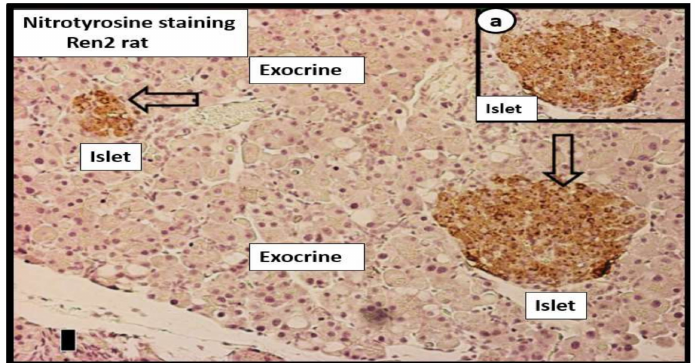
Figure 5. Immunohistochemistry of 3-nitrotyrosine staining in the Ren2 lean hypertensive preclinical rat model. This representative image demonstrates the strong di ff use antibody staining for 3-nitrotyrosine (a direct marker of nitrosative stress and an indirect marker of oxidative stress (RONS) in two islets (open arrows) in the 10-week-old transgenic Ren2 model (Ren2C) pancreas indicating intra-islet oxidative stress. Note that there is no staining in the adjacent exocrine portion of the pancreas. Insert a . demonstrates the di ff use intra-islet staining of 3-nitrotyrosine in the Ren2 model. Importantly, there was no staining for 3-nitrotyrosine in islets or exocrine portion of the age-matched Sprague–Dawley control model (not shown). Magnification: × 20 objective; scale bar = 5 µ m. Courtesy JOP [22]. RONS = reactive oxygen and nitrogen (nitrosative stress)